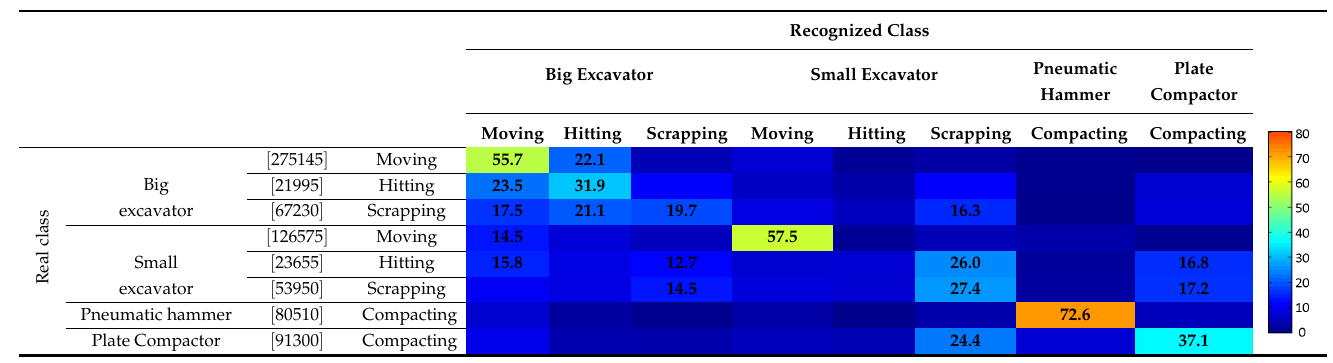
Table 6. Confusion matrix of the multi-position approach for detecting threats to the pipeline integrity for N = 11 position- based GMM training for the machine + activity identification mode. Each cell contains the classification accuracy. The values shown between brackets denote the number of frames that belong to the real class.